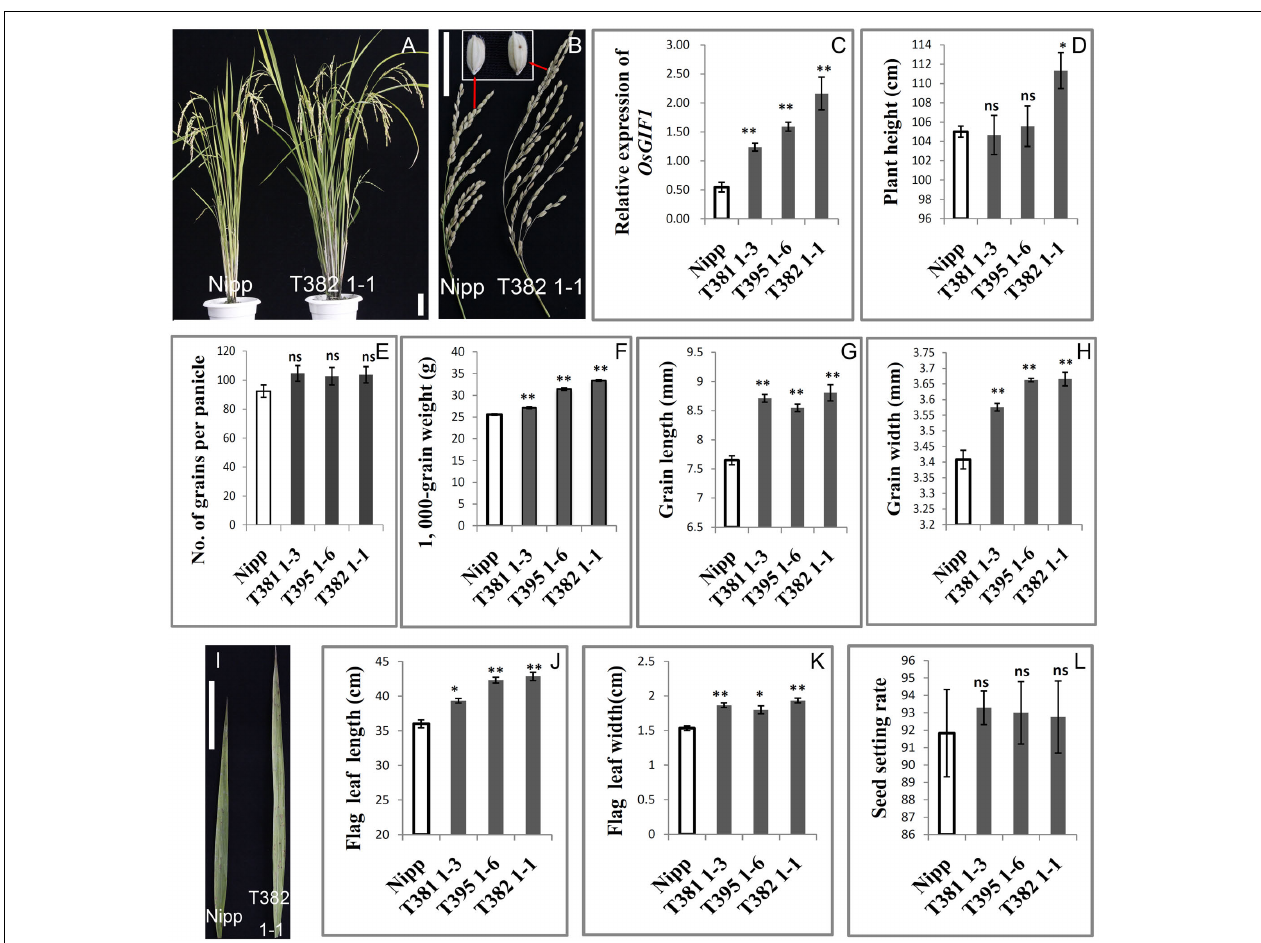
FIGURE 3 | Increase in the size of multiple rice organs caused by overexpression of OsGIF1. Comparisons of several important traits between the OsGIF1 overexpression and control plants. (A) Plant phenotype; (B) panicle and grain; (C) relative expression level of OsGIF1 ; (D) plant height; (E) number of grains per panicle; (F) 1000-grain weight; (G) grain length; (H) grain width; (I) leaf; (J) flag leaf length; (K) flag leaf width; and (L) seed setting rate. Scale bars: 10 cm. Values are all shown as mean ± SEM ( n = 3). Asterisks indicate significant differences between the WT and overexpression plants as determined by Student’s t -test: ns, not significant; ∗∗ p ≤ 0.01; ∗ p ≤